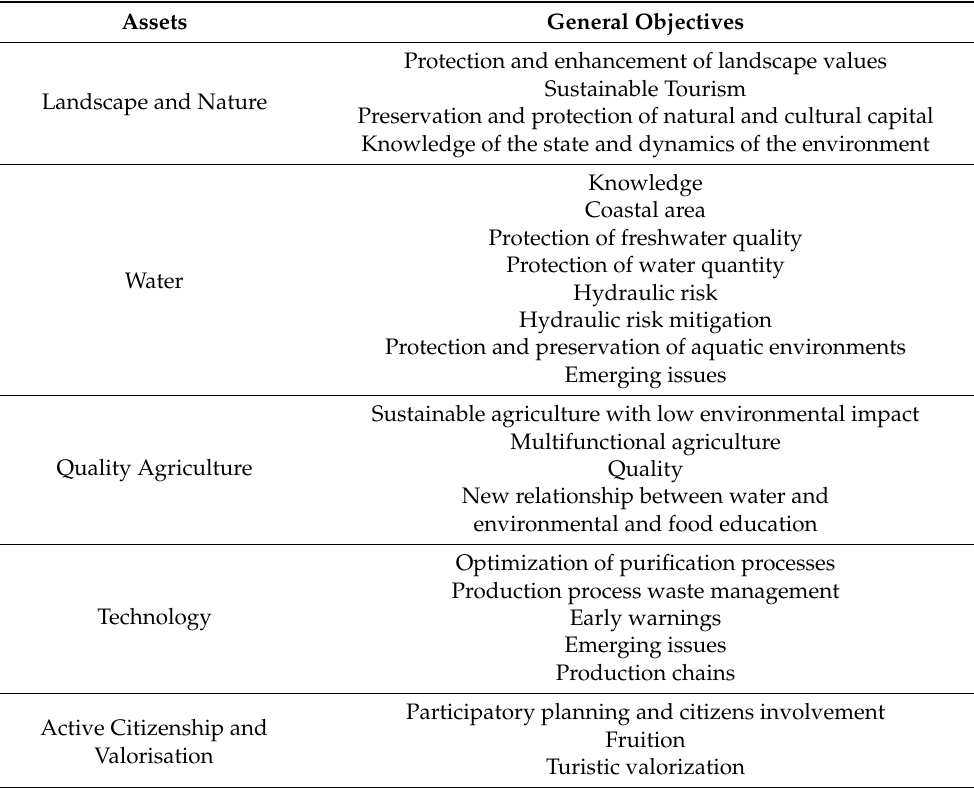
Table 3. The five assets and general objectives of the River, Coastal, and Landscape Contract Arrone defined in the Document of Intent (Phase 1). Source: authors’ elaboration (2022) from data of the official web site of the contract avaiable at https://contrattodifiumearrone.it/documentazione- progettuale/ (accessed on 20 July 2022).